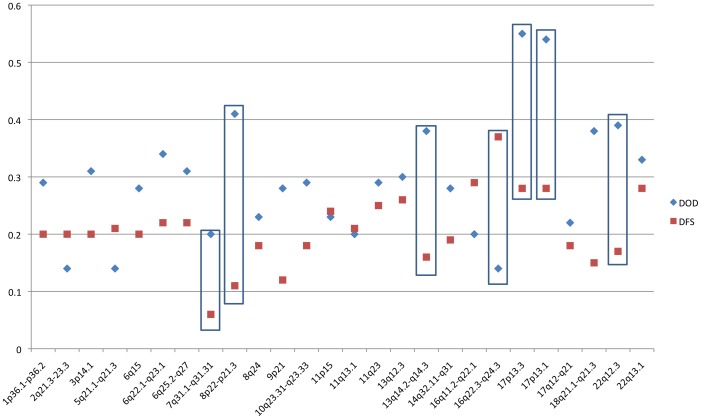
Scatter plot of levels of AI by chromosomal region.Chromosomal regions are on the x-axis, average level of AI on the y-axis. Chromosomes with significantly different frequencies between DOD and DFS groups are boxed.